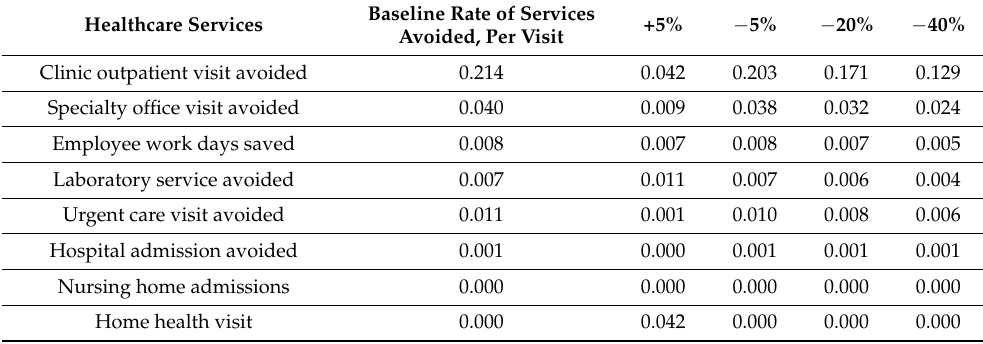
Table 7. Sensitivity analysis—rates of avoided healthcare